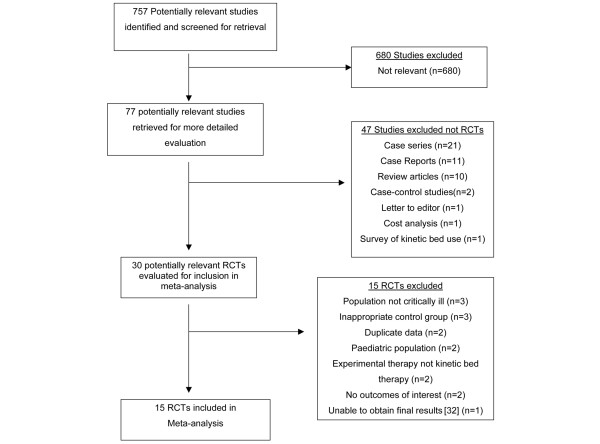
QUOROM Flow diagram summarizing trial flow and reasons for exclusion of studies. RCT, randomized clinical trial.